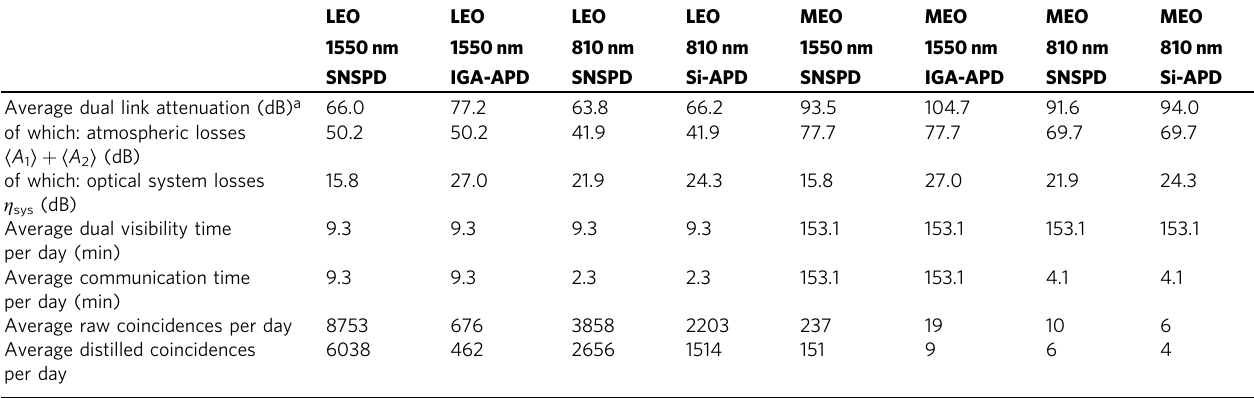
Table 3 Simulations results for a low Earth orbit (600-km altitude) and a medium Earth orbit (8000-km